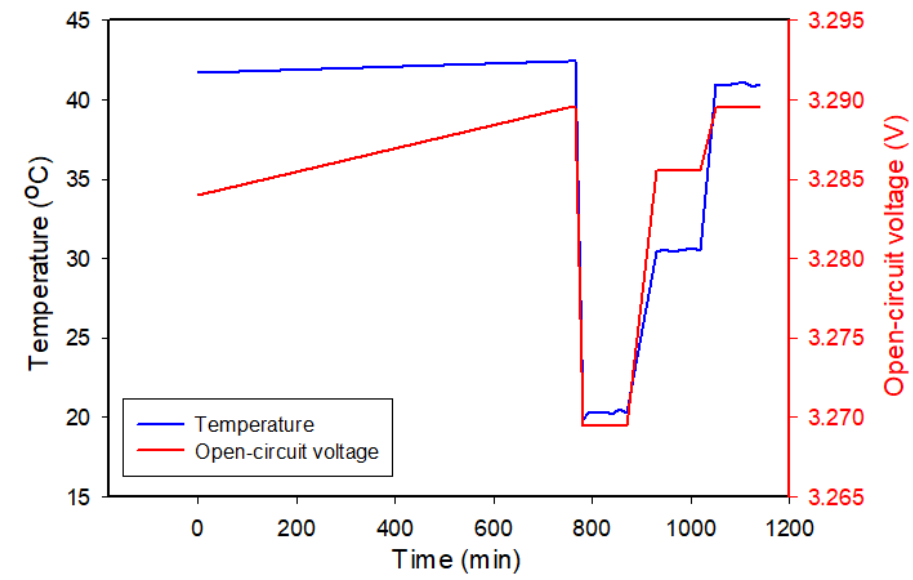
Figure 7. The change in open-circuit voltage of the LFP prismatic cell at 0.6 SOC .